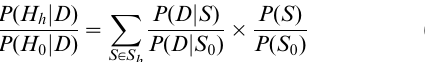
Figure S2 Simulation analysis with a shared causal variant between two studies, comparing results using imputed versus not imputed data where the causal SNP is not included in one of the datasets. The two datasets used are one eQTL (sample size 966 samples) and one biomarker, and each plot shows different sample sizes for the biomarker dataset. The variance explained by the causal variant for both the traits is colour coded. Column and